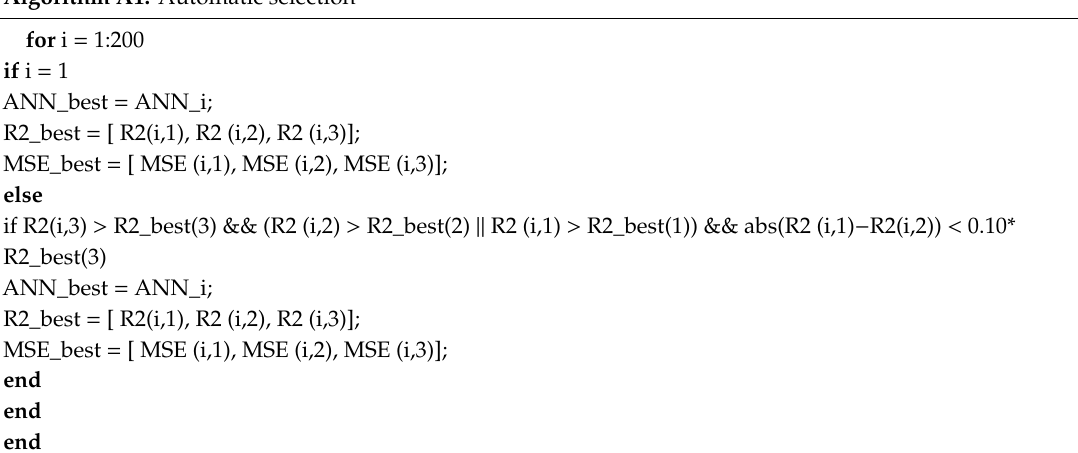
Algorithm A1. Automatic